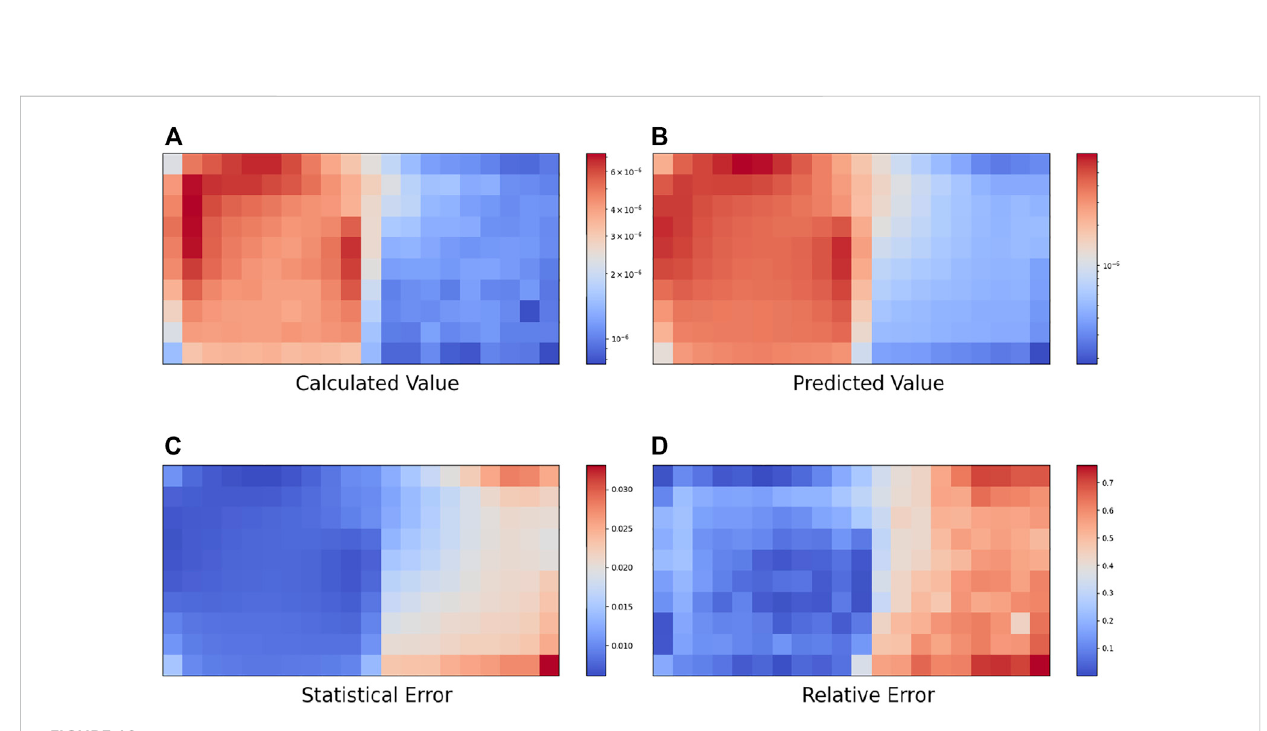
FIGURE 10 Reconstruction results of the double-point source